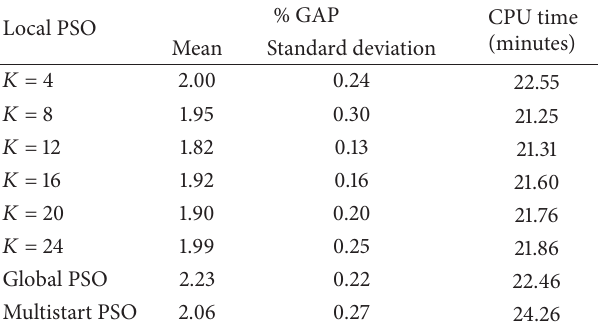
Table4:NumericalresultsofdifferentvariantsofthePSOalgorithm in the case of problem